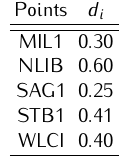
Table 1. Displacements at network points